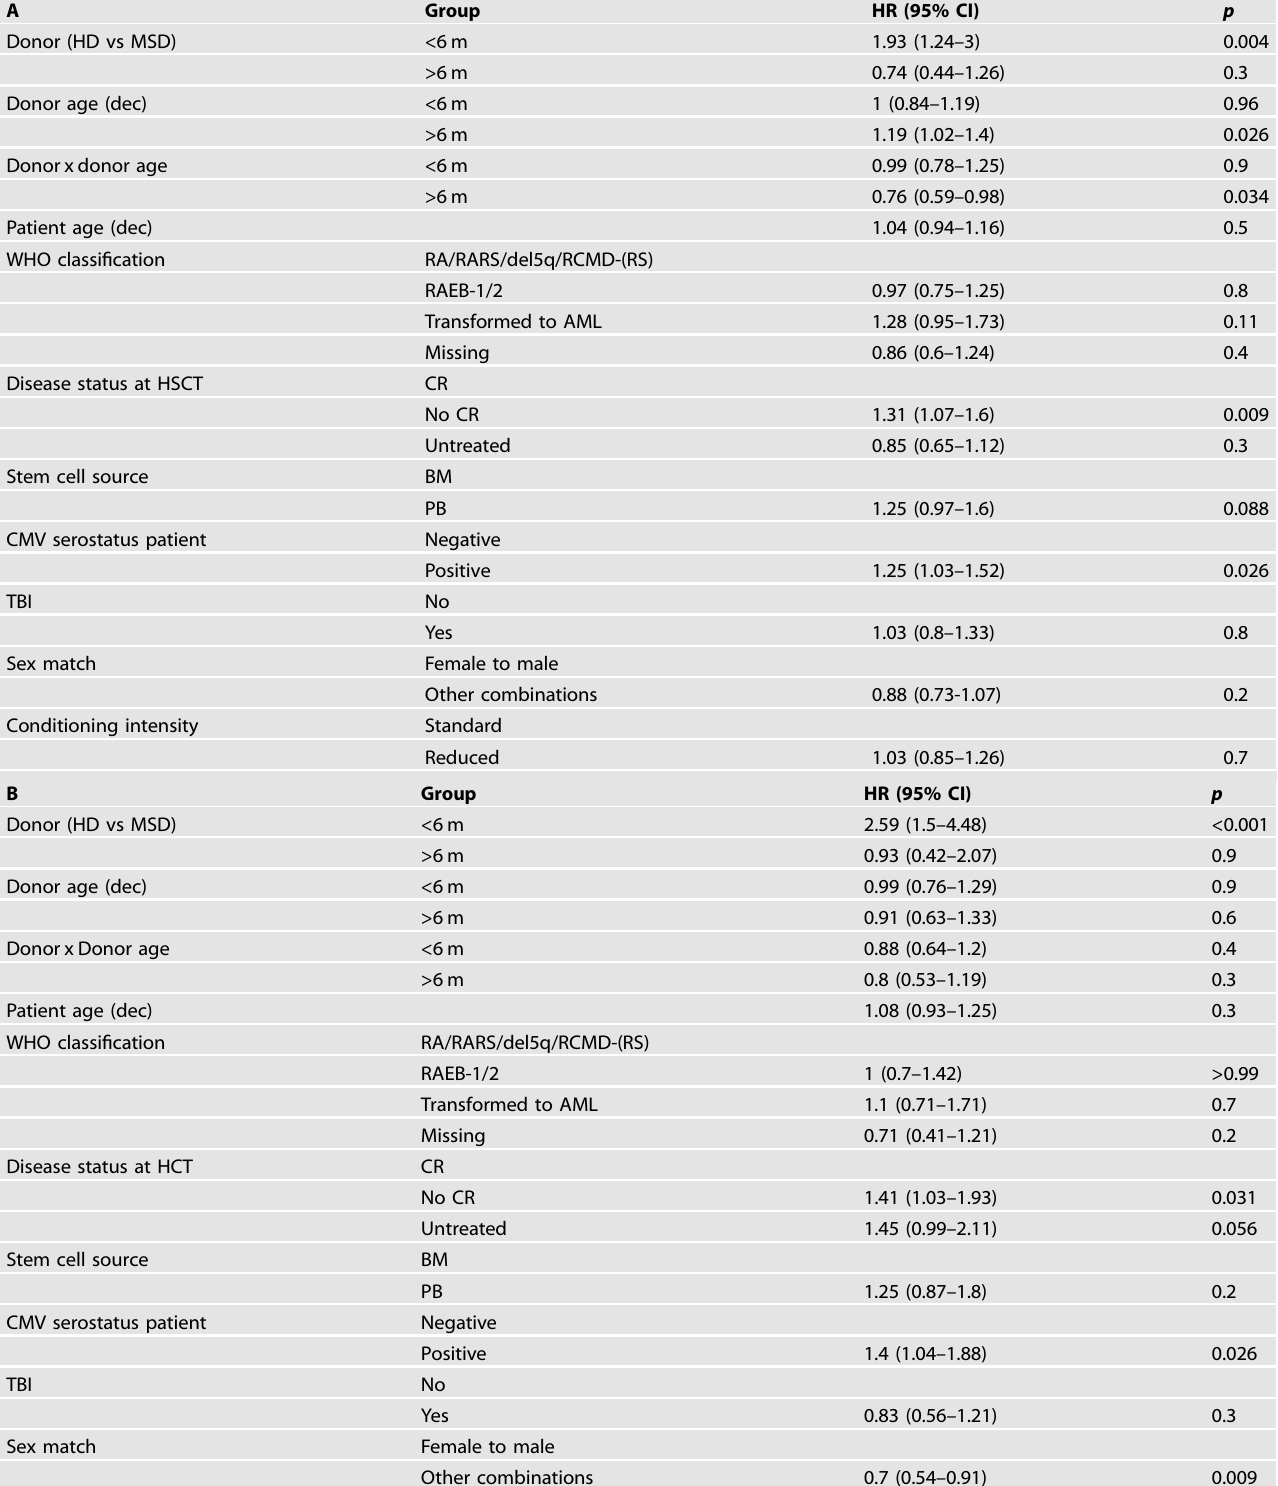
Table 3. Multivariate analysis of factors affecting Outcomes. A Multivariate analysis for factors affecting OS. B Multivariate analysis of factors affecting NRM. C Multivariate analysis of factors affecting PFS. D Multivariate analysis of factors affecting relapse. E Multivariate analysis of factors affecting graft